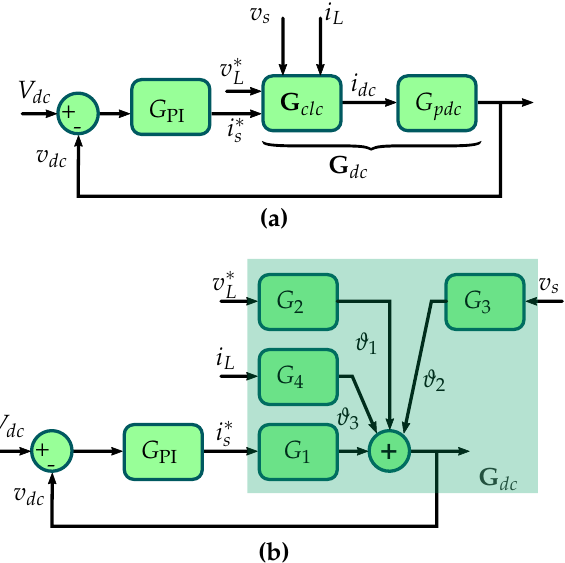
Figure 6. Closed loop system reduction to achieve PI controller tuning for the DC-link